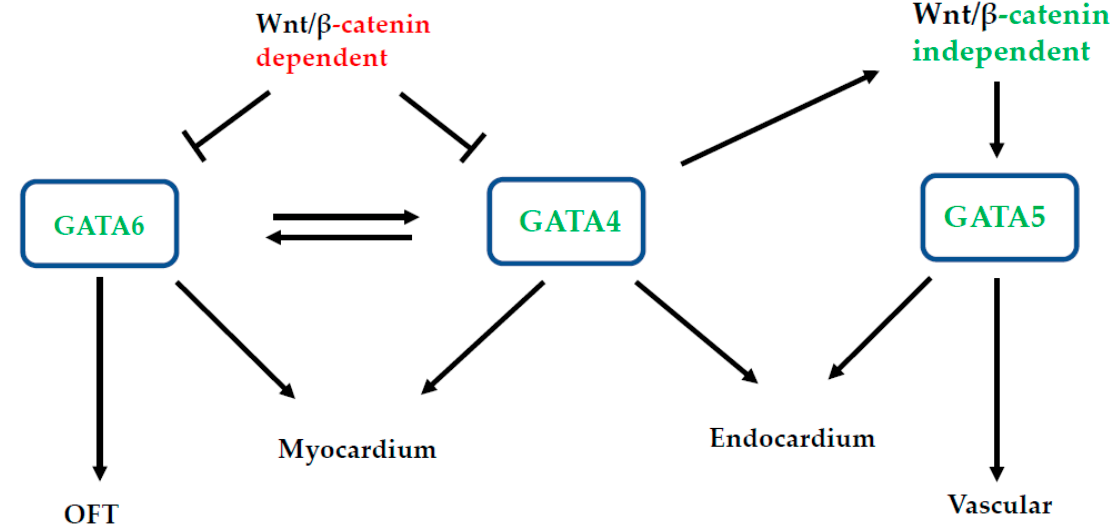
Figure 4. Proposed summary of Gata functions in heart development.